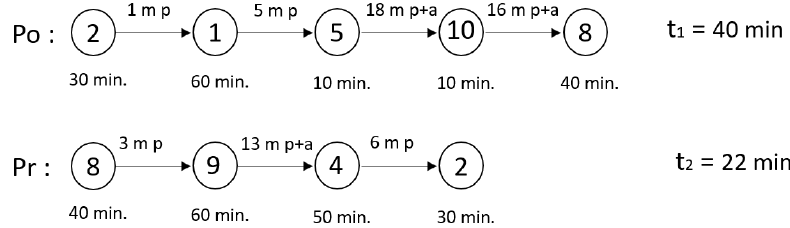
Figure 16. Algorithm 1.1 exchanges node 4 of G o with node 10 of G r